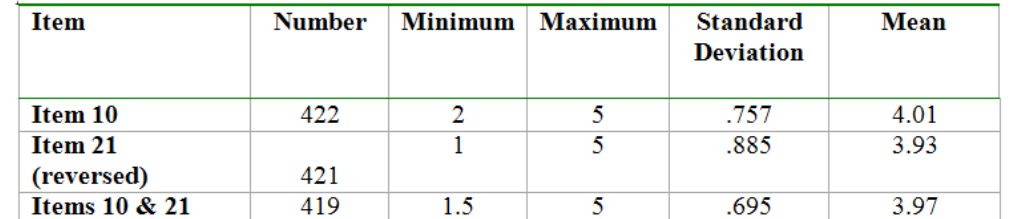
Table 4. Student learning satisfaction item